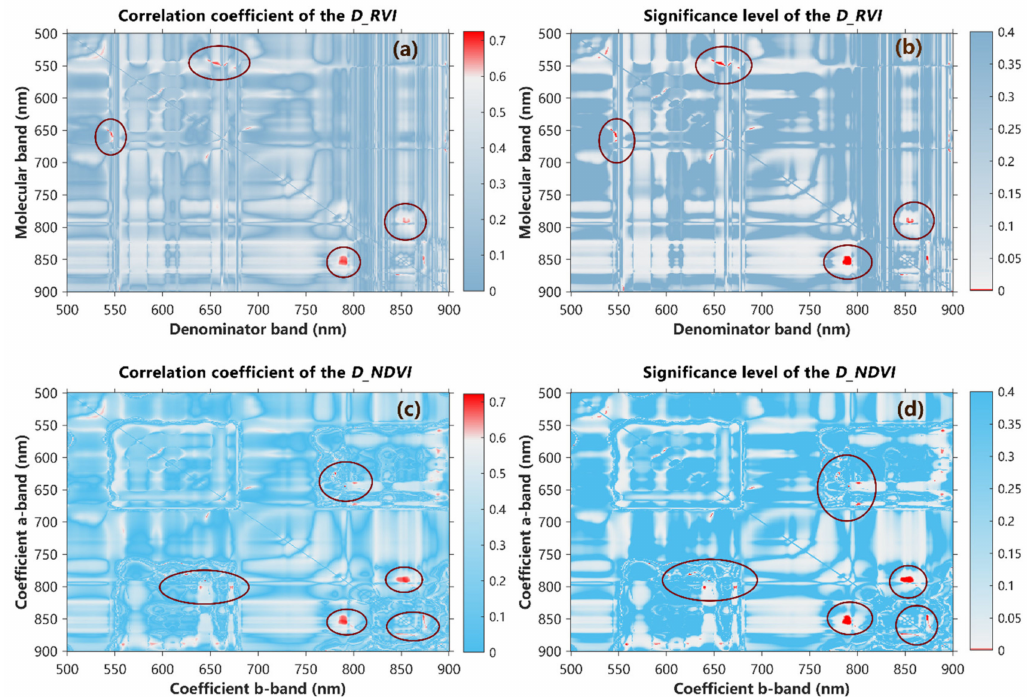
Figure 6. The correlation coe ffi cient matrix ( a ) and significance level matrix ( b ) between the ratio vegetation indices based on derivative reflectance ( D_RVI ) and total chlorophyll content, and the correlation coe ffi cient matrix ( c ) and significance level matrix ( d ) of normalized di ff erence vegetation indices (NDVI) based on derivative reflectance ( D_NDVI ) and total chlorophyll content. The red regions indicate the significance level p < 0.001.